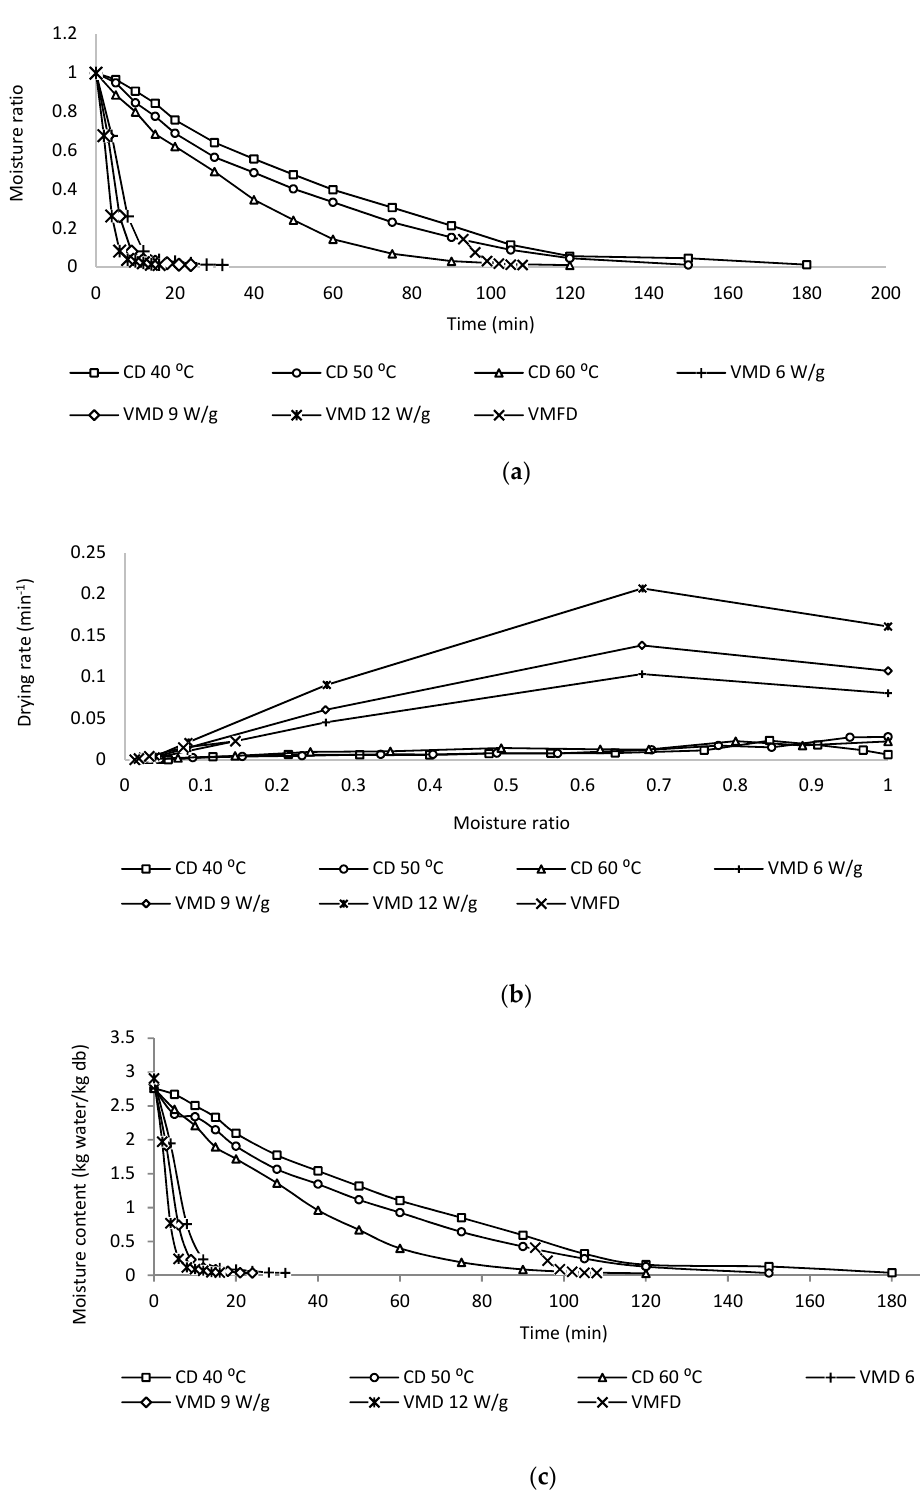
Figure 1. ( a ) Relationship between moisture ration (MR) and time. ( b ) Drying rate against MR. ( c ) Relationship between moisture content and time for the drying of C. alata at convective drying (CDs) at 40 °C, 50 °C and 60 °C, vacuum microwave drying (VMD) at 6, 9 and 12 W/g and convective pre-drying followed by vacuum microwave finish drying (CPD-VMFD) at 50 °C and 9 W/g.